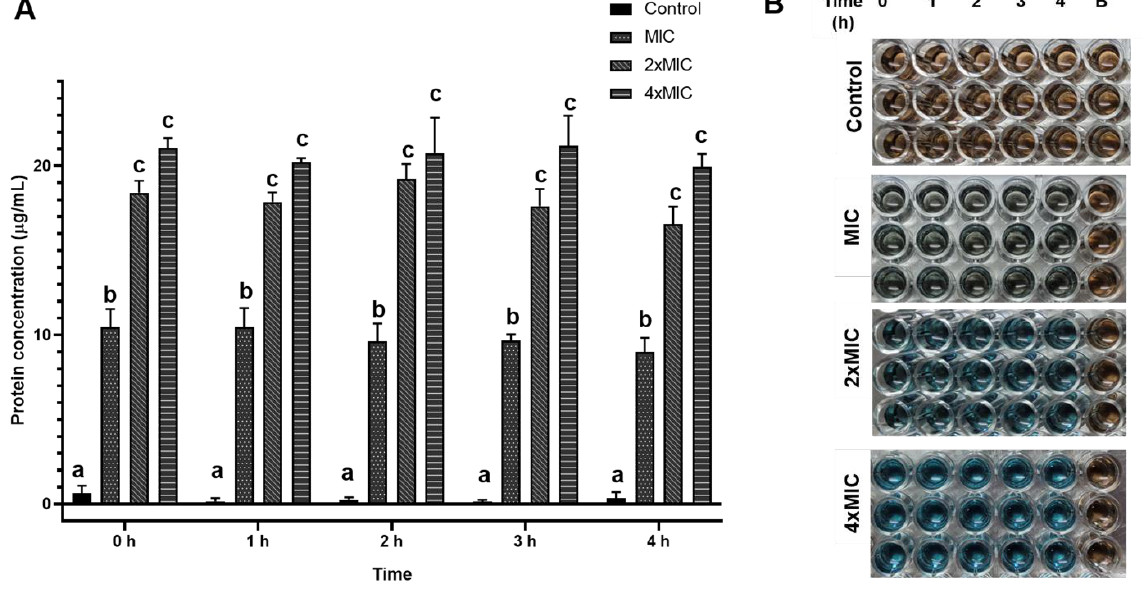
Figure 5. Quantitative ( A ) and qualitative ( B ) analyses of protein leakage of L. monocytogenes treated with COS-EGCG conjugate at various concentrations for different times. The different letters on the bars denote significant differences ( p < 0.05). The results are presented as means ± SD ( n = 3). The blue color indicates the presence of protein when tested using the Bradford assay.